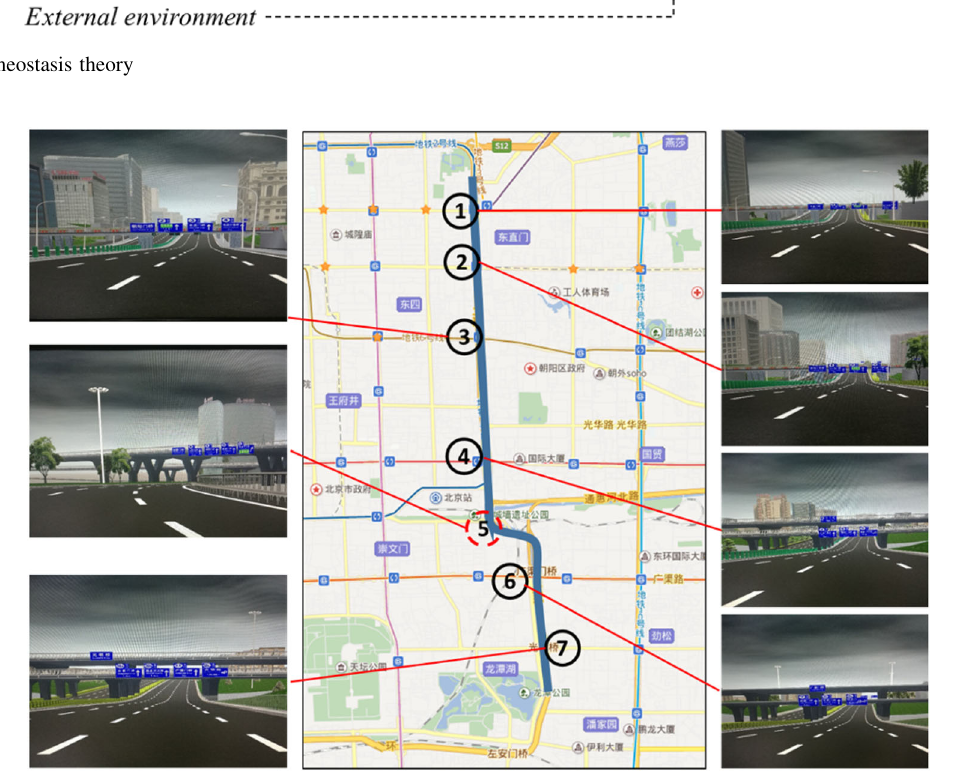
Fig. 2 Overall simulation